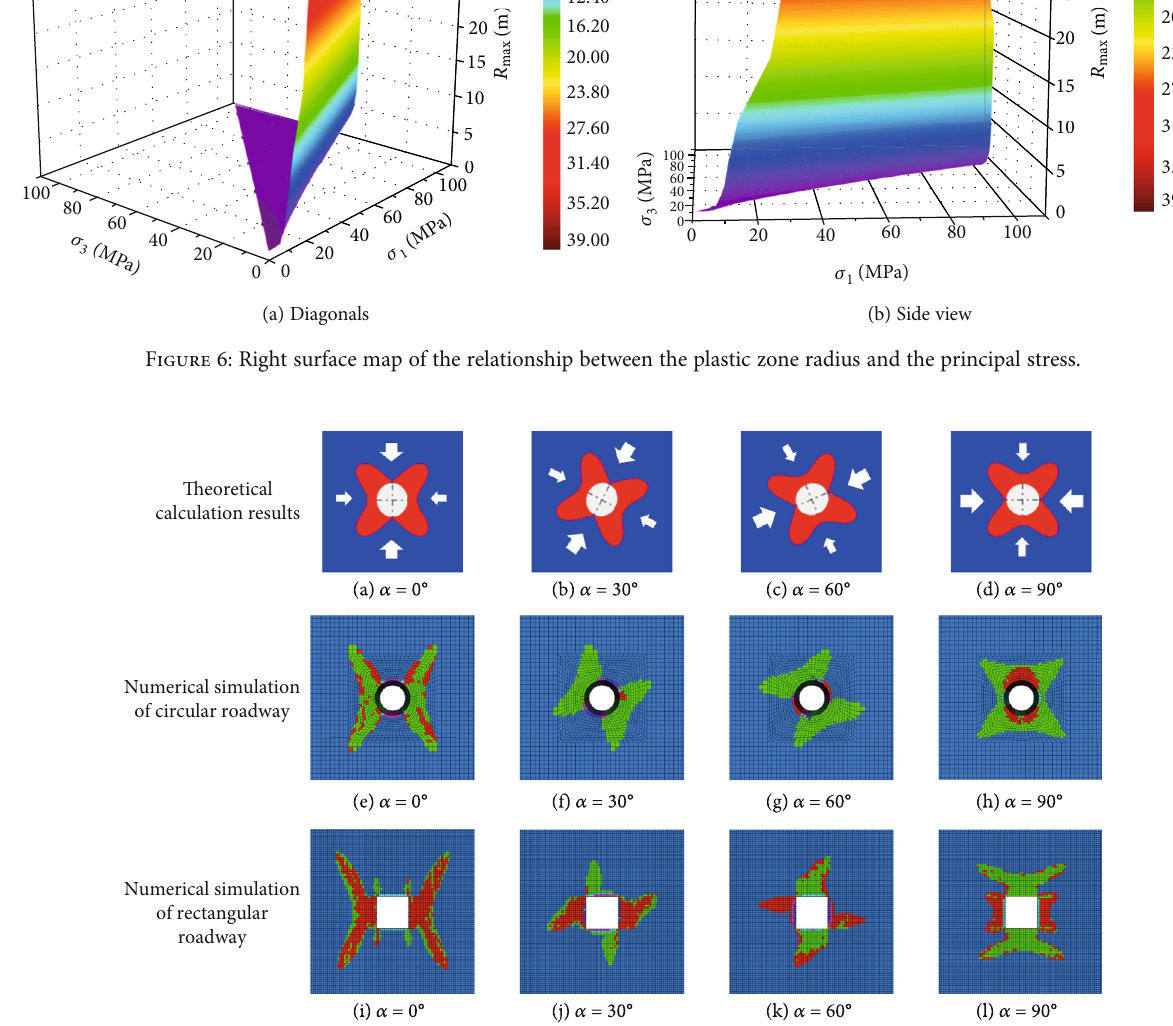
Figure 7: Principal stress de fl ection of surrounding rock in the circular roadway at di ff erent angles of the butter fl y plastic zone distribution